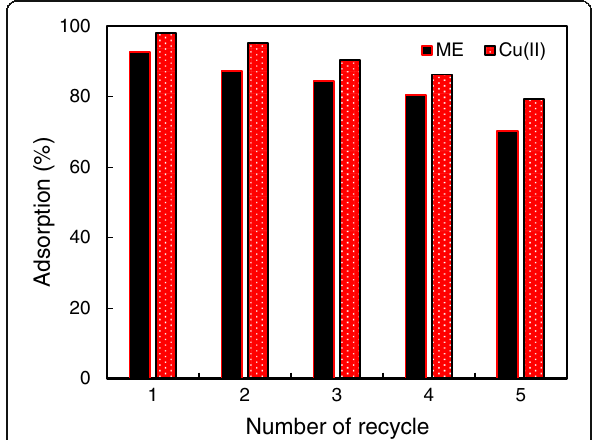
Fig. 12 Reuse of AS-MPs adsorbents by ME and Cu(II) cations